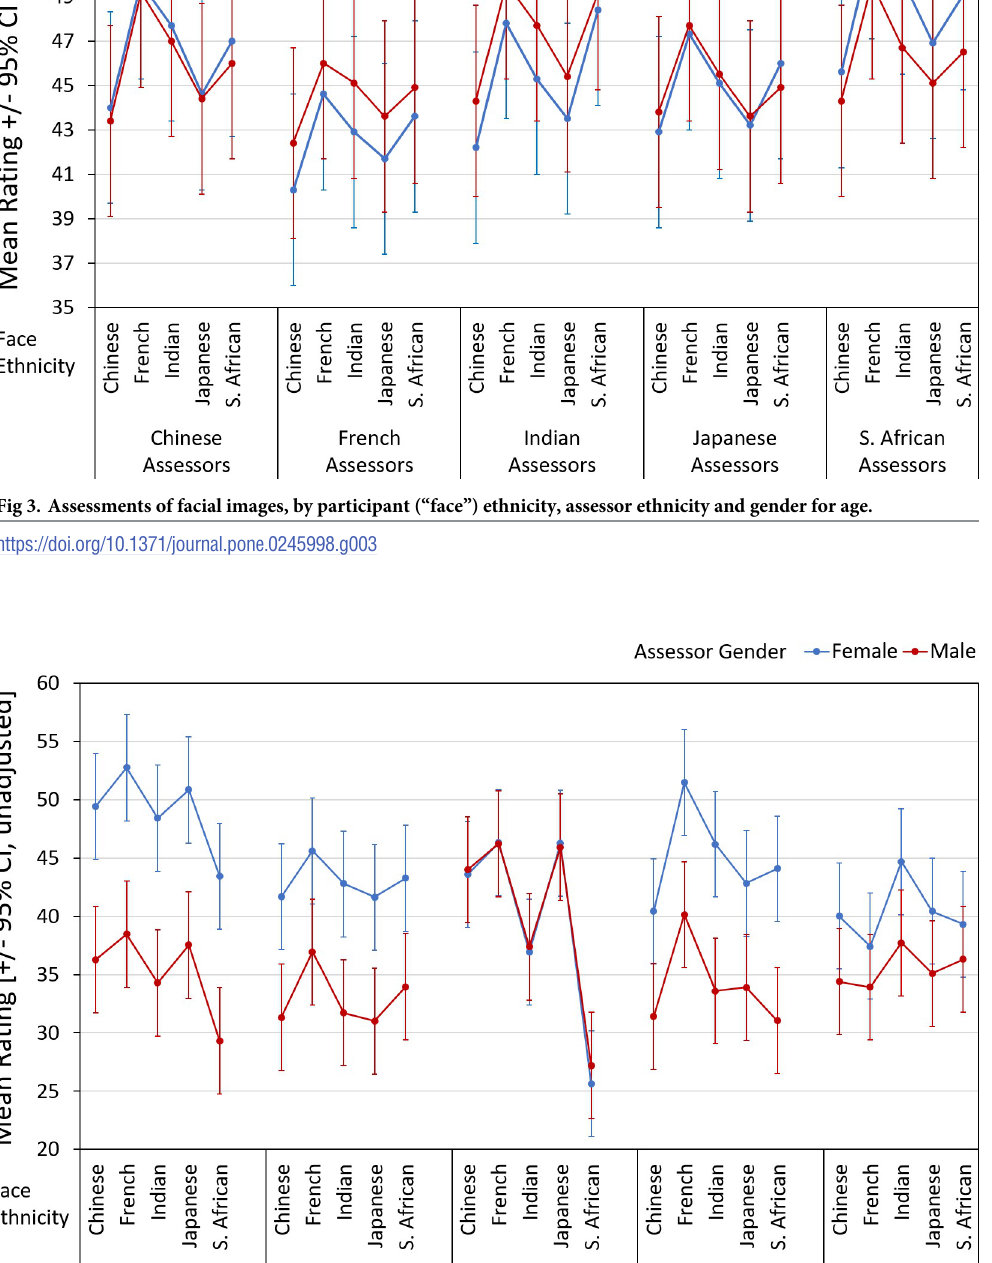
PLOS ONE | https://doi.org/10.1371/journal.pone.0245998 January 22,